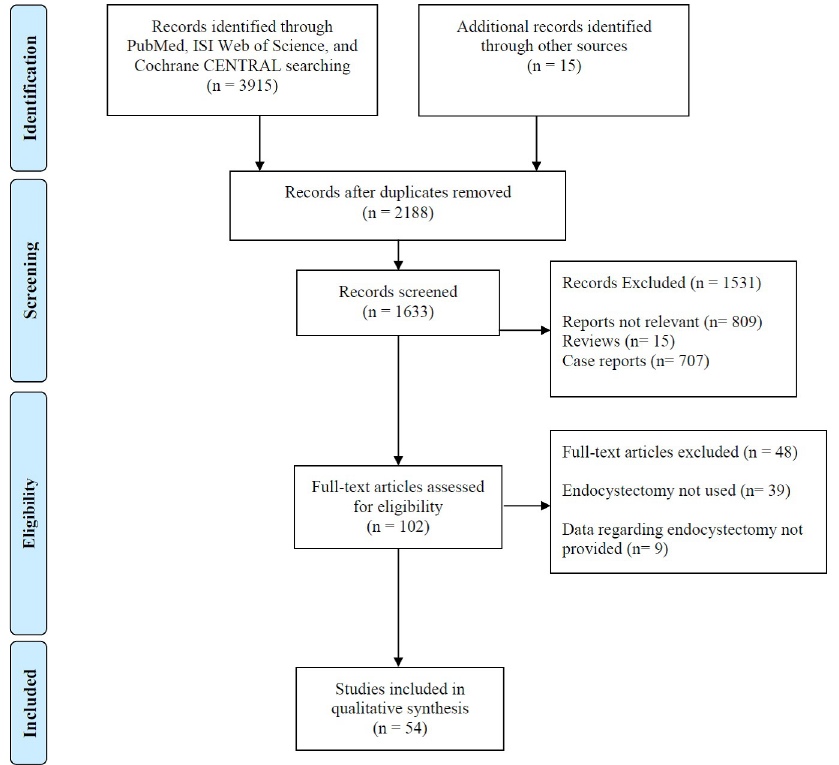
Fig 1. PRISMA flow-chart showing selection of articles for